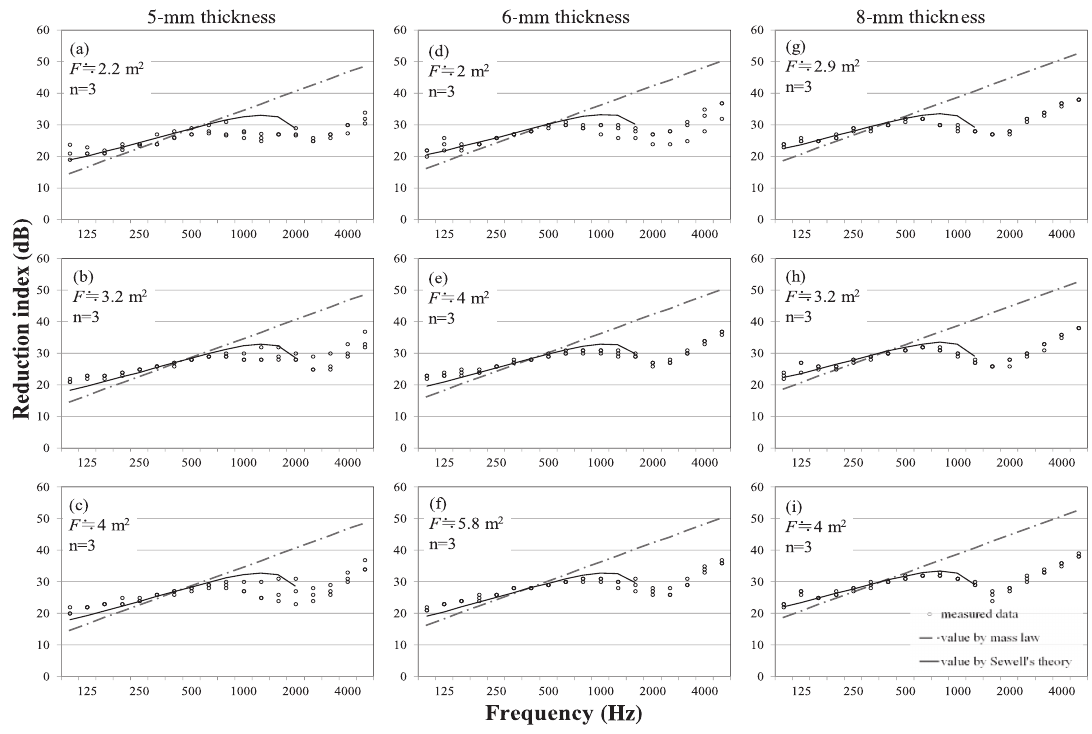
Reduction indices of sliding window with theories. Solid lines and dash– dotted lines, respectively, represent values using Sewell’s theory and values using the mass law. Plots show measured data of windows in the 1/3 octave. ‘F’ and ‘n’ represent the window area and the number of the samples, respectively.